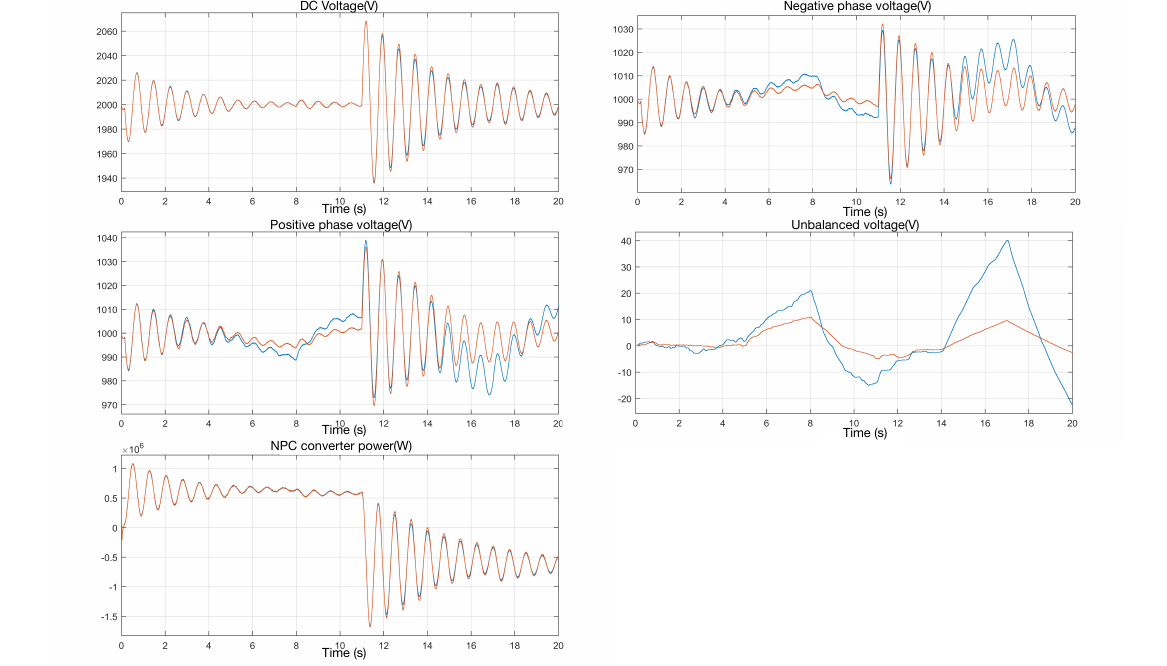
Figure 15. Simulation of traditional control and control with voltage